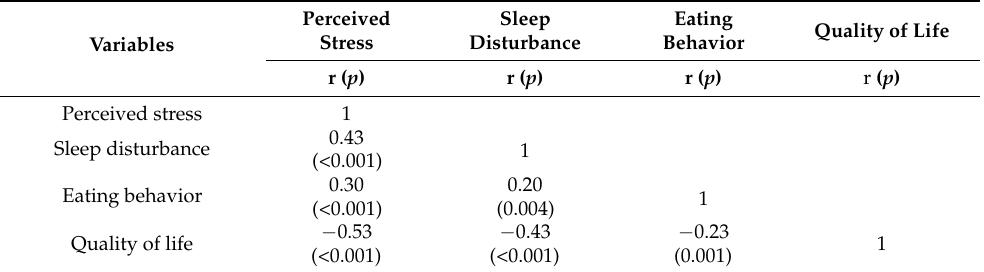
Table 3. Correlations among perceived stress, sleep disturbance, eating behavior, and quality of life ( N =